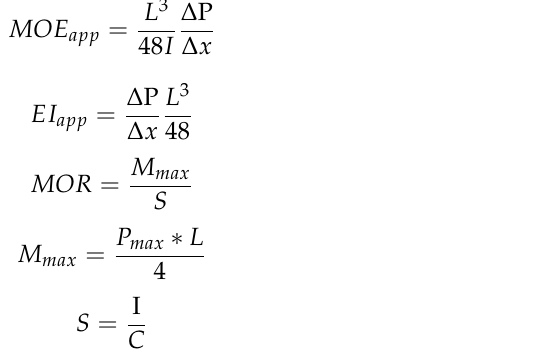
Figure 1. A schematic of loading conditions of specimens under experimental bending test. Using the experimental test, the apparent modulus of elasticity ( MOE app ), the apparent bending stiffness (EI app,exp ), and the modulus of rupture ( MOR ) values of samples were calculated based on the following Equations according to the ASTM D198 standard [30].